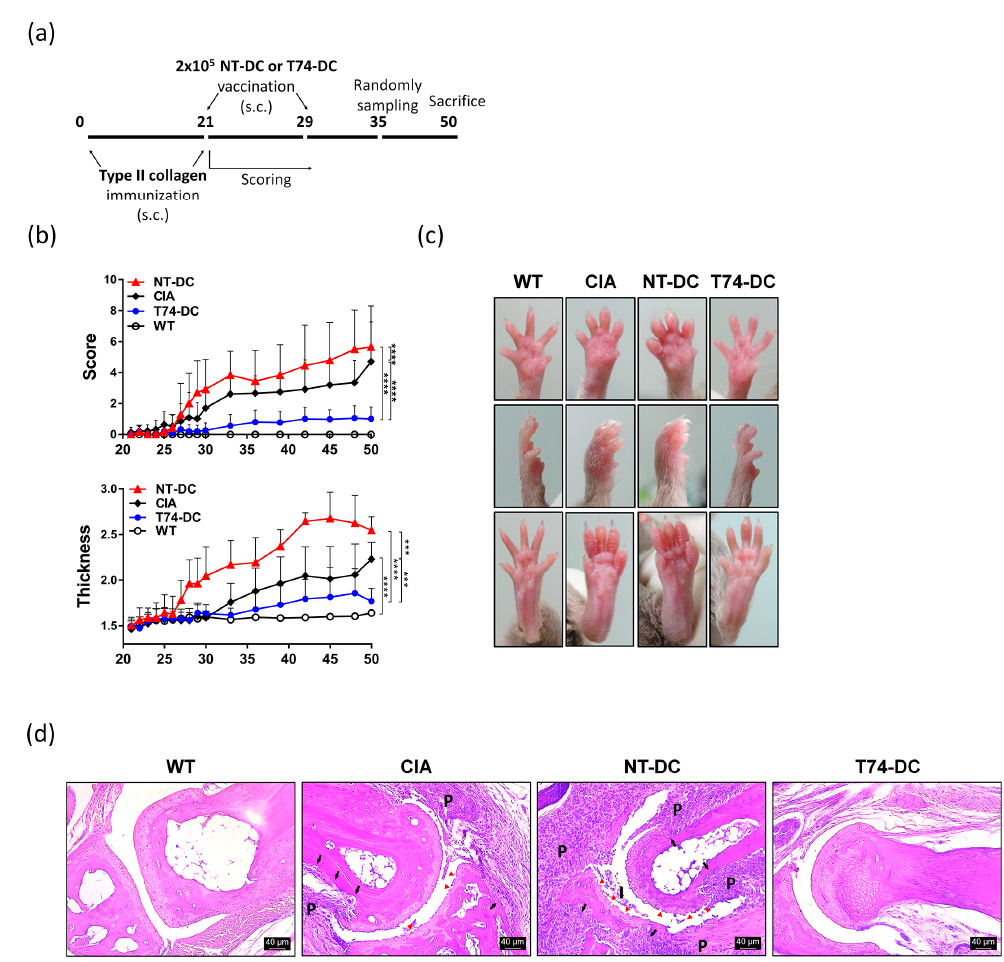
Figure 5. Type II collagen-primed T74-DCs attenuate CIA progression. DBA/1J mice were injected subcutaneously with 100 µ L type II collagen (CII) emulsion. Mice were immunized boost dose with the same amount of collagen on Day 21 after the primary immunization. Established CIA mice were vaccinated with 2 × 10 5 CII-primed T74-DCs, NT-DCs, or PBS twice on Days 21 and 29. ( a ) Schematic diagram of the animal experiment. ( b ) Arthritis incidence was observed by clinical scoring and footpad thickness from Day 21 until the end of experiment. Severity was scored on a scale of 0–4 for each paw. Data are expressed as the mean ± SEM (wild type: 6 mice, other groups: 10 mice). ( c ) Paws of mice from each group were randomly selected and photographed. Images show the front ( top ) and side ( middle ) of the front paws and the hind paws ( bottom ). ( d ) Paws removed from half mice in each group were fixed in 4% paraformaldehyde, decalcified for 3 weeks in HCl solution, and then embedded in paraffin. 5 µ m thick serial sections were stained with H&E. Data are representative of the staining per each group (wild type: n = 3, other groups: n = 5). Bone and cartilage erosion are marked with black arrows and red arrowheads, respectively. P: pannus, I: inflammatory exudate. *** p < 0.001, **** p < 0.0001.